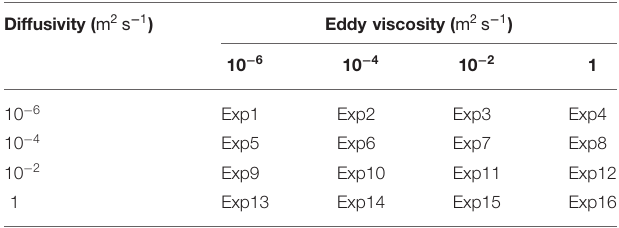
TABLE 1 | Overview of model experiments and applied